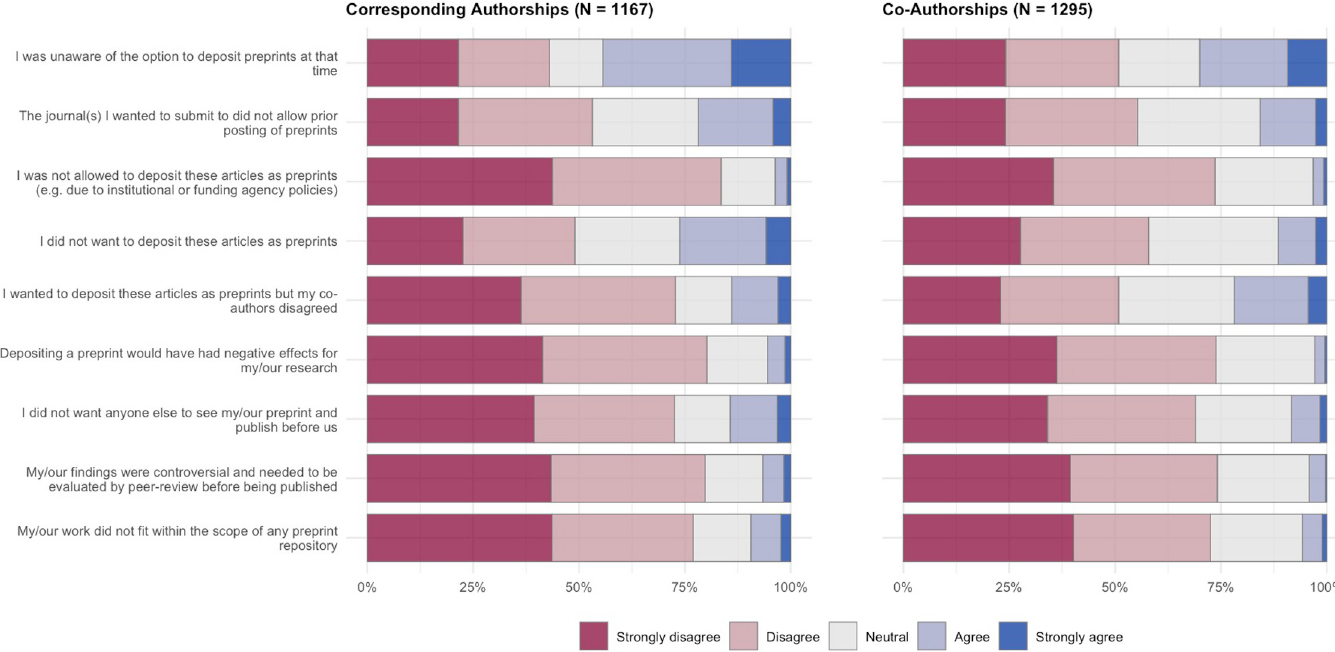
Fig 8. Differences between articles posted as preprints versus those not posted as preprints. Results show answers to survey questions on a 5-point Likert scale, divided by articles that authors published as a corresponding author (left) and articles that authors published as a co-author (right).